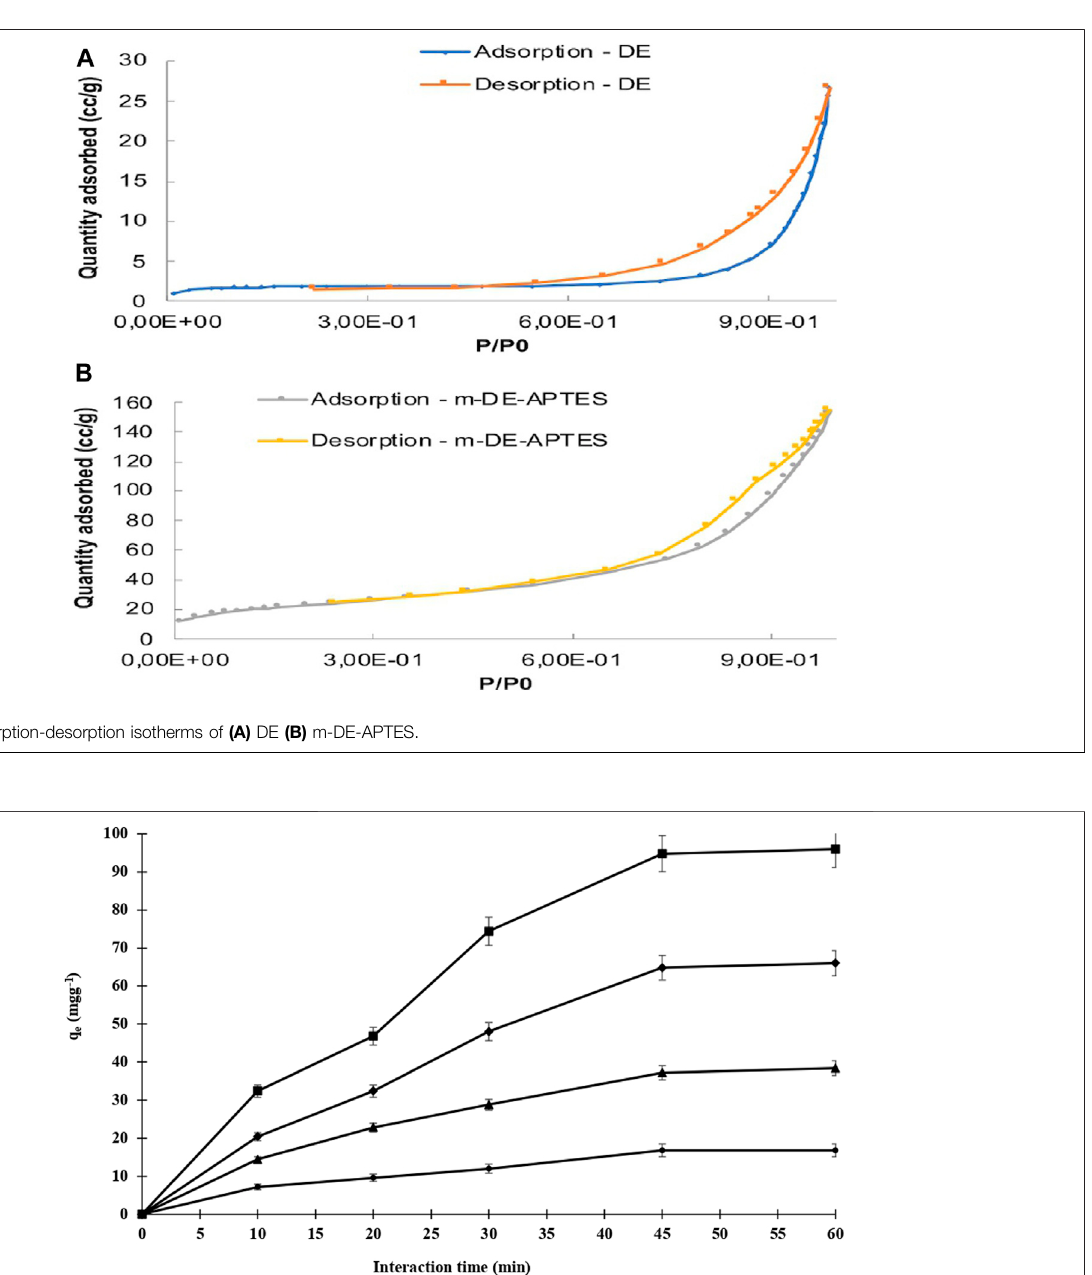
Frontiers in Chemistry |